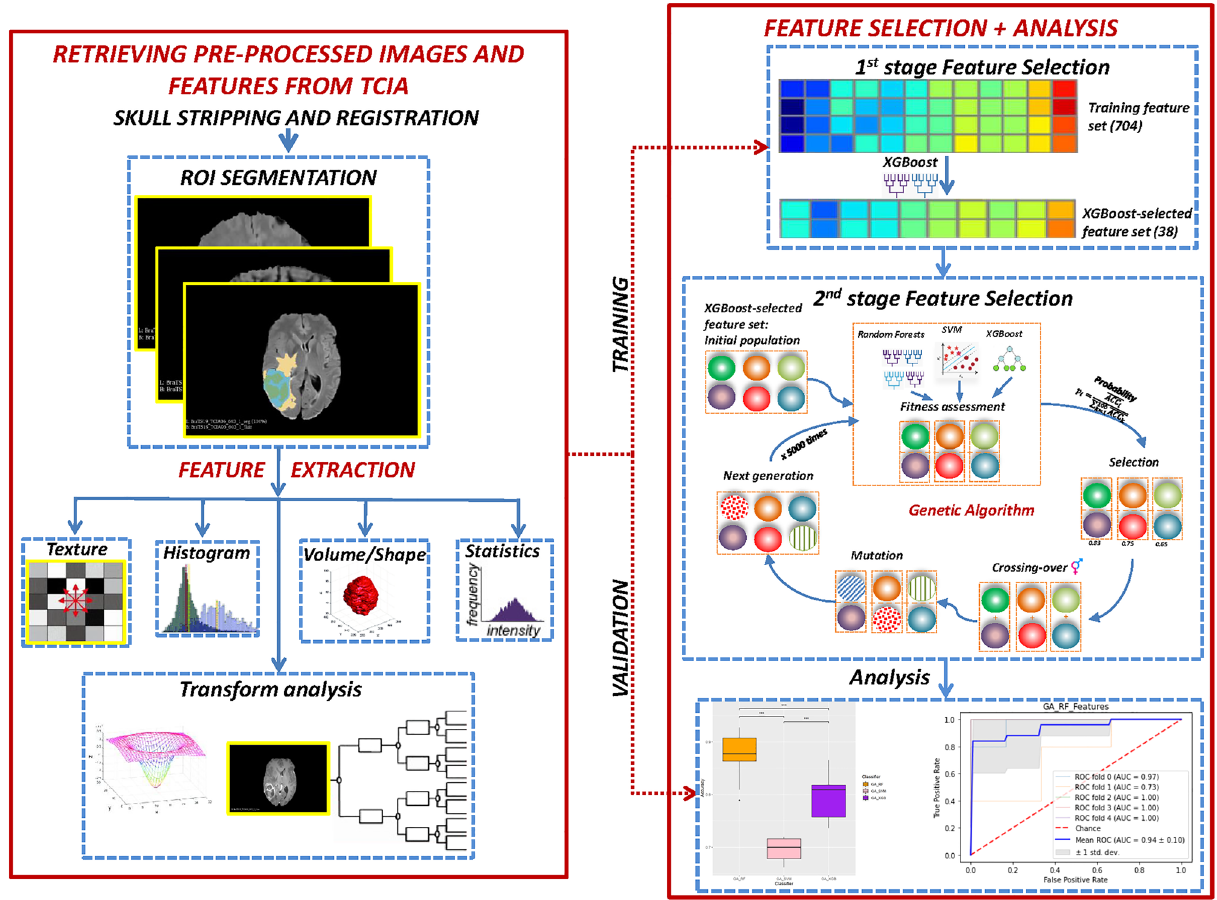
Figure 1. The overall feature selection steps. The left part demonstrates the pre-processing and segmentation steps while the right part list the two-stage feature selection procedure. The extracted feature set is then evaluated for its